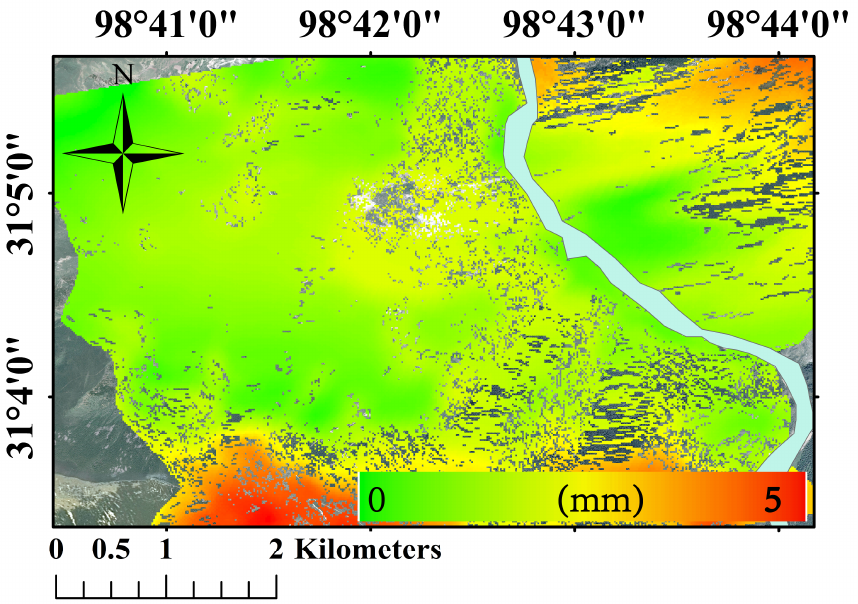
Figure 10. Average STD of the deformation time series in the Markov model after subtracting phase unwrapping.